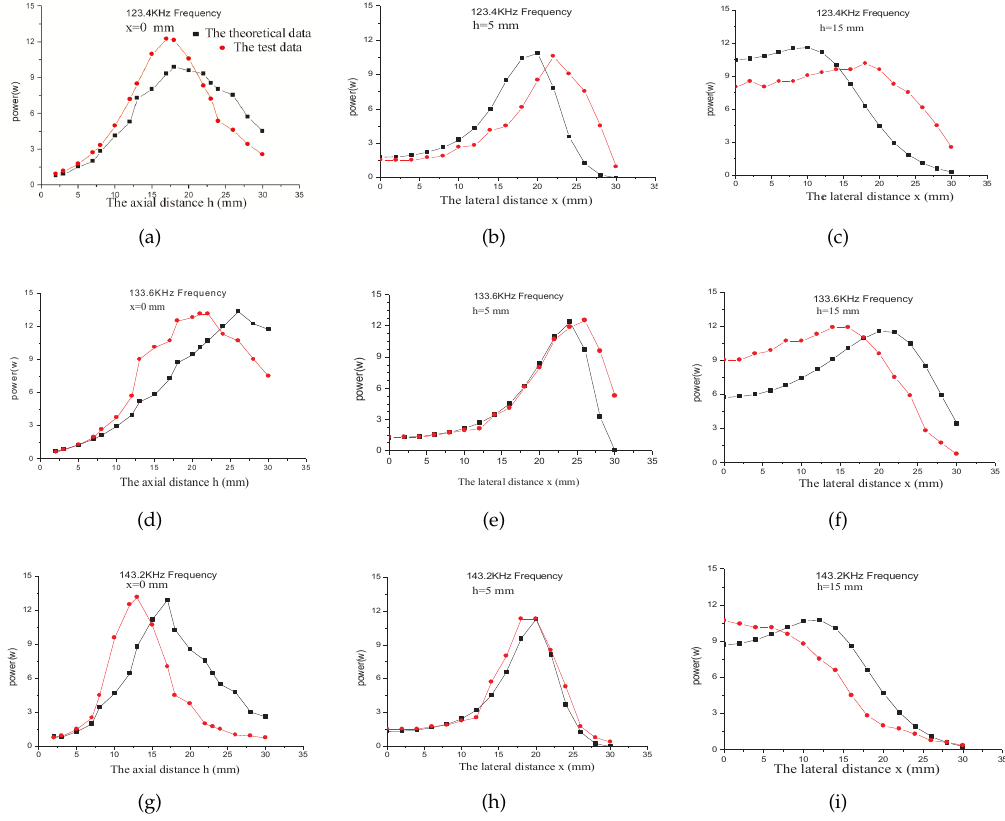
Figure 9. Changing curve of the load power with the simulation frequency and the distance of